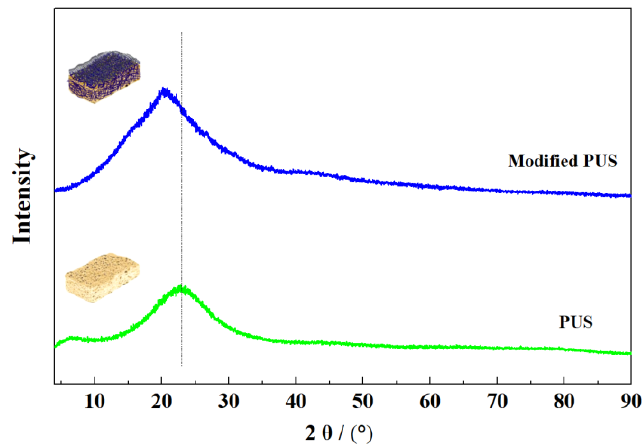
Figure 8. The XRD patterns of the PUS before and after modification.